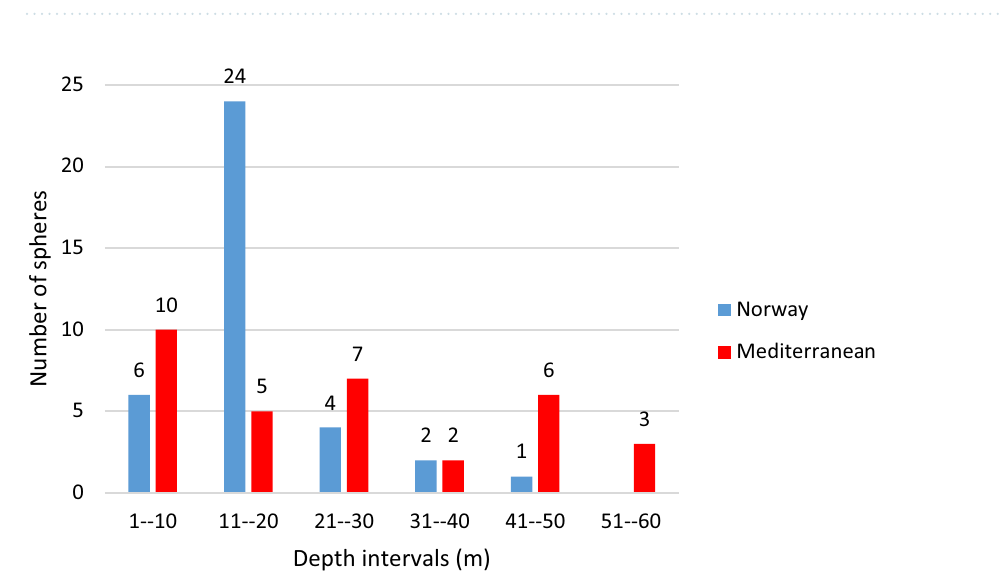
Figure 6. Sphere observations throughout the year, during ~ 1985 to 2019, from NE Atlantic Ocean, including the Mediterranean Sea.